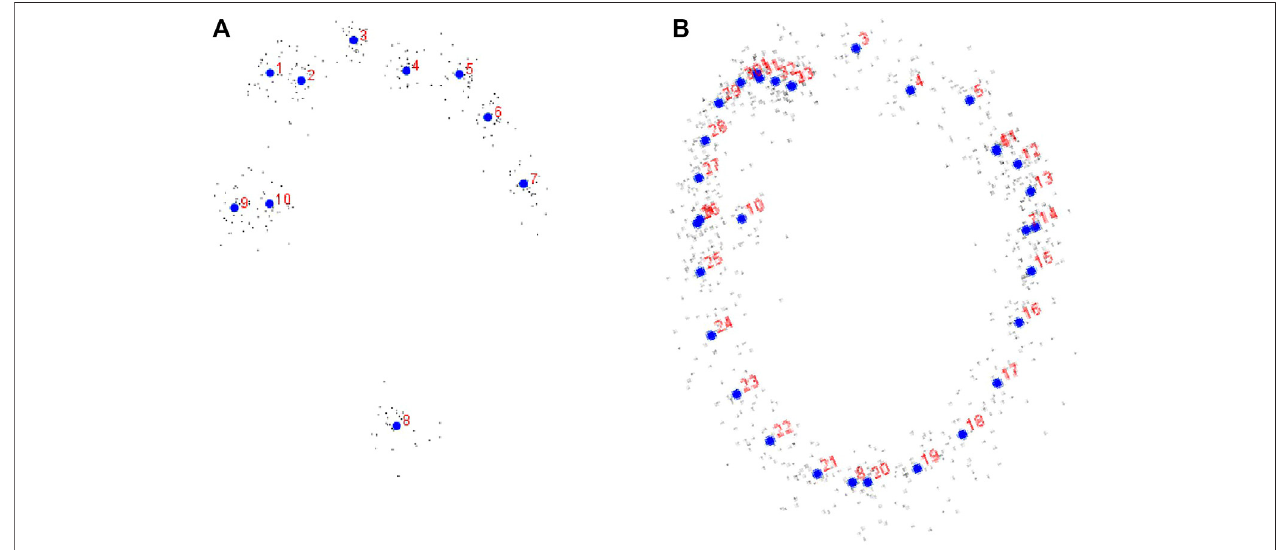
FIGURE 7 | (A) Procrustes coordinates with large blue dots (centroids), labelled 1 – 10, representing the consensus coordinates and the deviation around them (small dots). (B) Curve landmarks (landmarks 11 – 33).